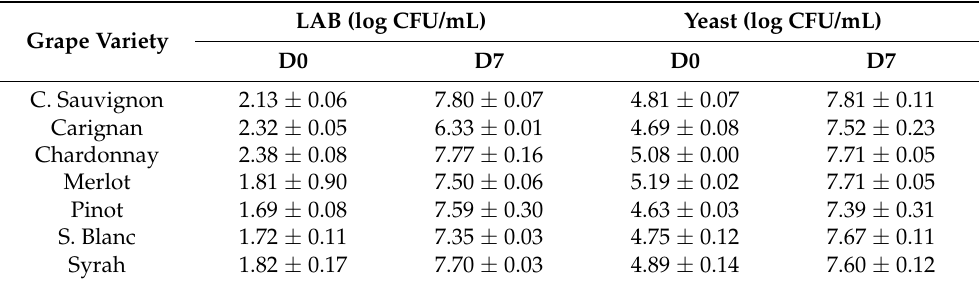
Table 1. Changes in lactic acid bacteria and yeast population observed during the spontaneous grape juices fermentation.